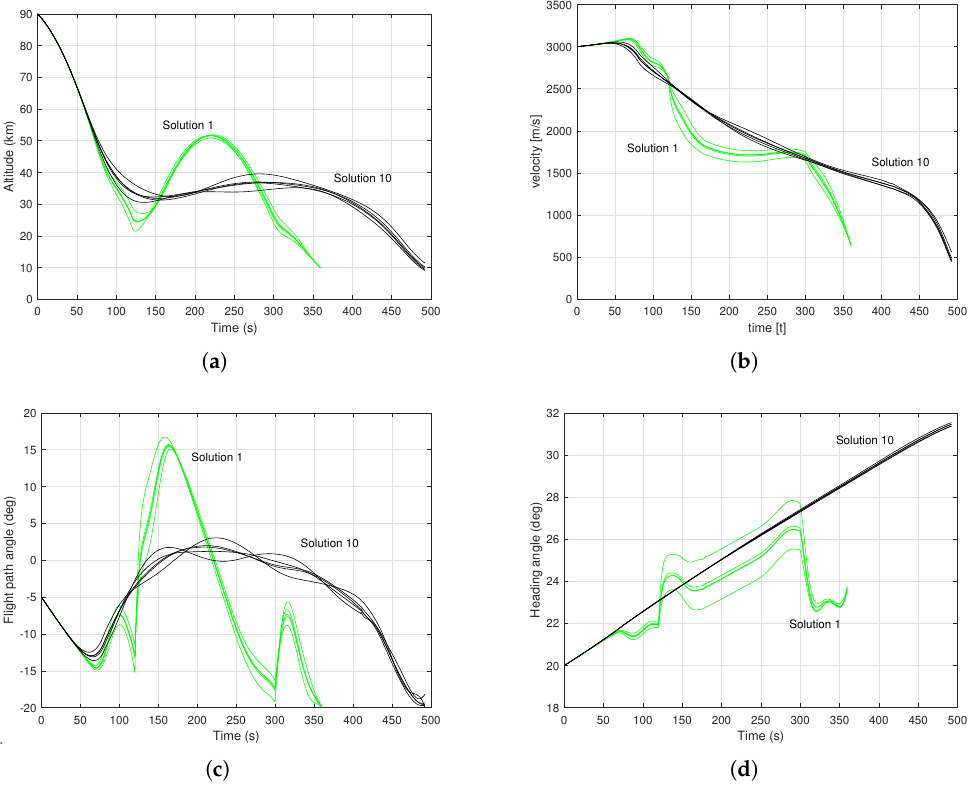
Figure 9. State variables of sigma points for the two extrema of the Pareto-optimal set (Solutions 1 and 10). ( a ) Altitude; ( b ) Velocity; ( c ) Flight path angle; ( d ) Heading